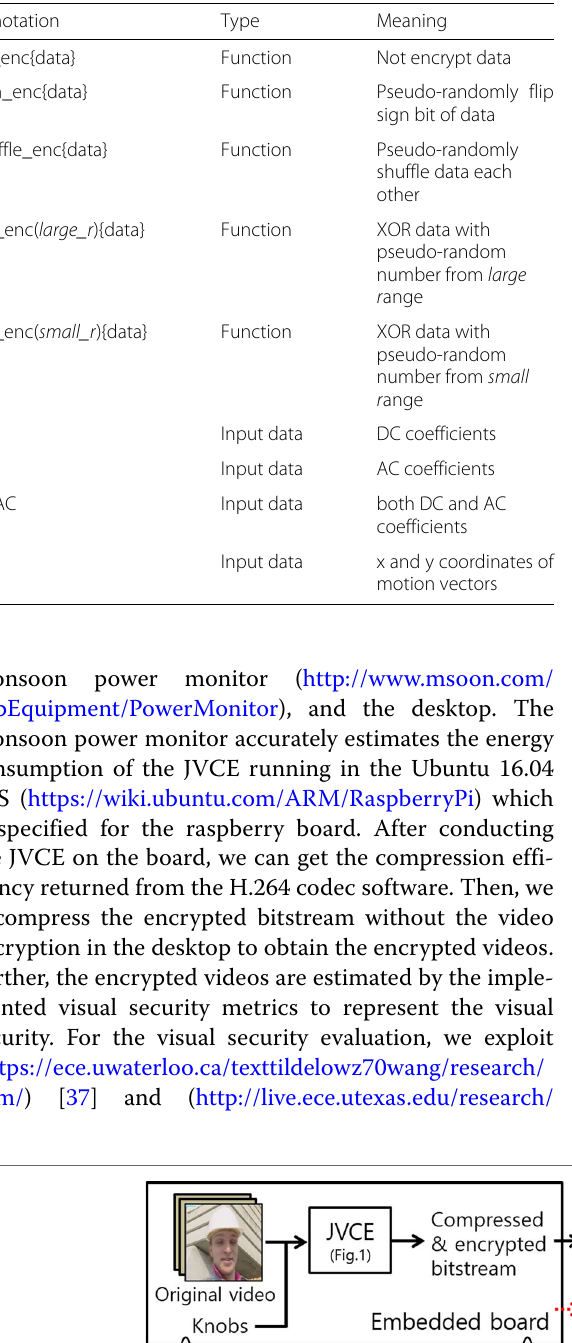
Table 2 Annotations to represent the video encryption functions and the data to be protected by the video encryption functions